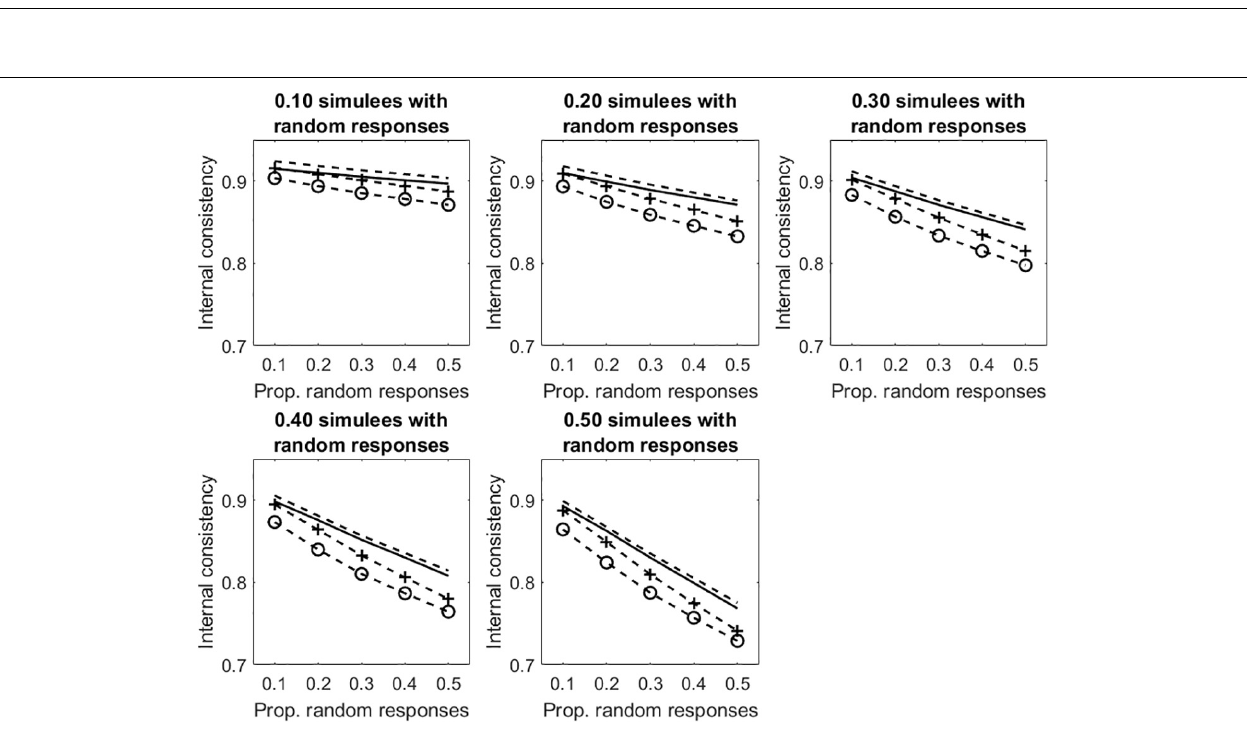
FIGURE 4 | Average internal consistency for the different proportions of simulees with random responses and the different proportions of dichotomous items with random responses. The solid line represents KR20, the unmarked dashed line represents R, the +-marked dashed line represents infit-corrected R, and the o-marked dashed line represents the outfit-corrected R.